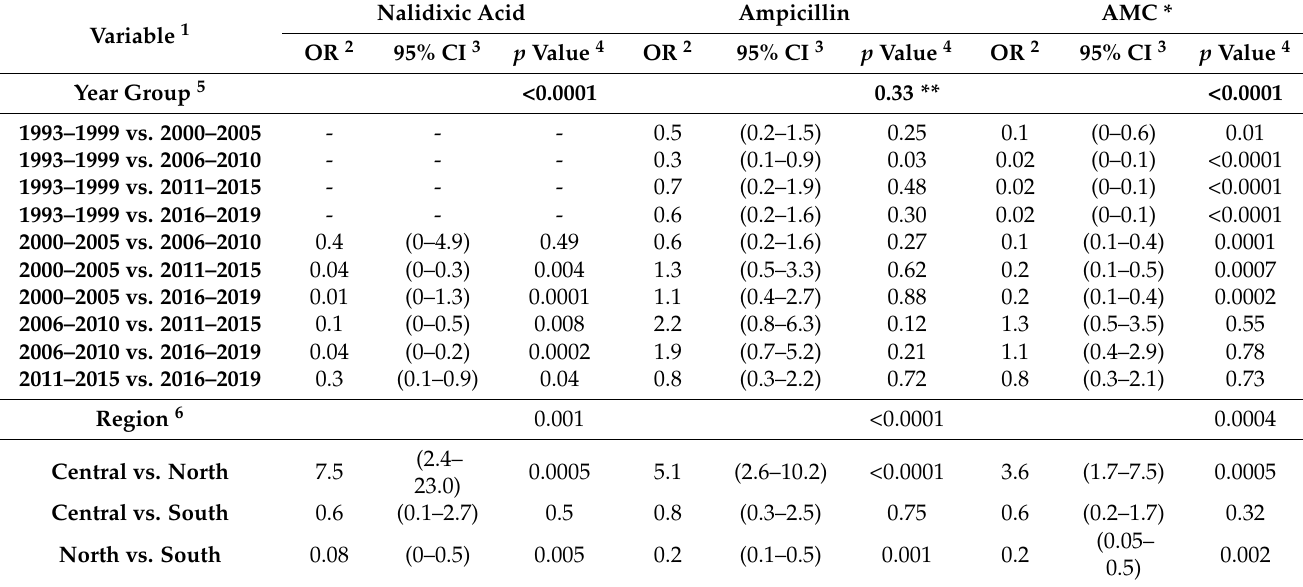
Table 7. Odds ratio for the effect of year group and region for a S. Dublin being classified as resistant for quinolones and aminopenicillins by antimicrobial class for antimicrobial drugs in the NARMS panel. p values in bold indicates significant odds ratio